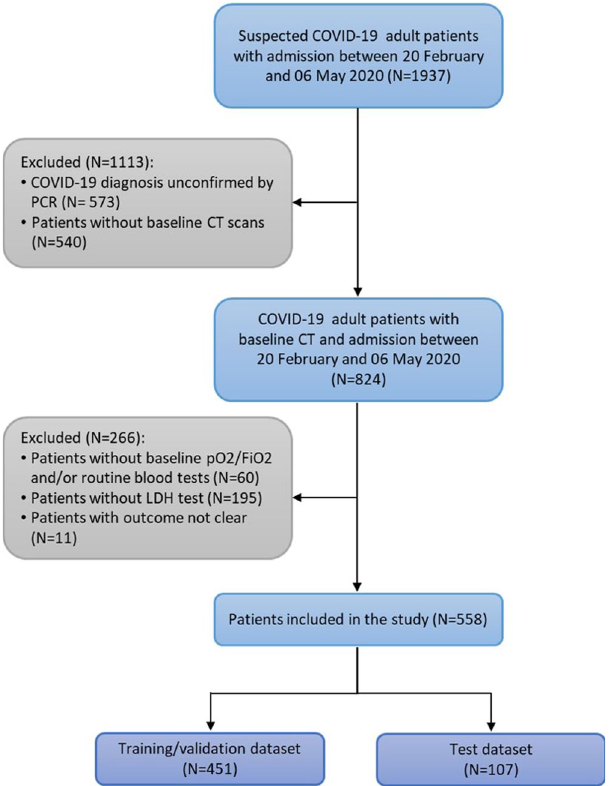
Figure 2. Flowchart of patients inclusion/exclusion.